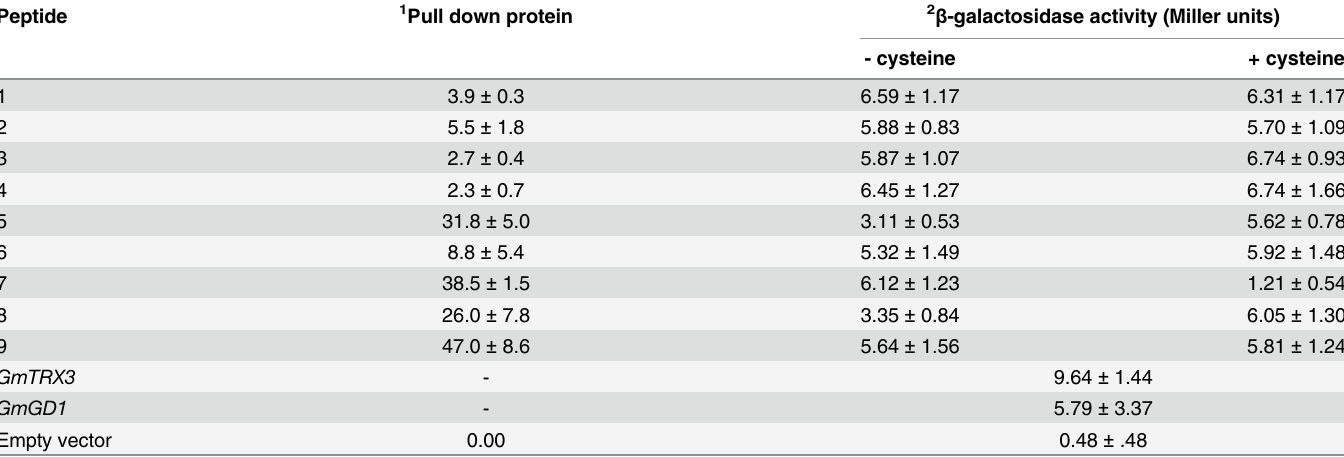
Table 4. In vitro and in vivo affinities of nine synthetic FvTox1-interacting peptides with FvTox1. Peptide